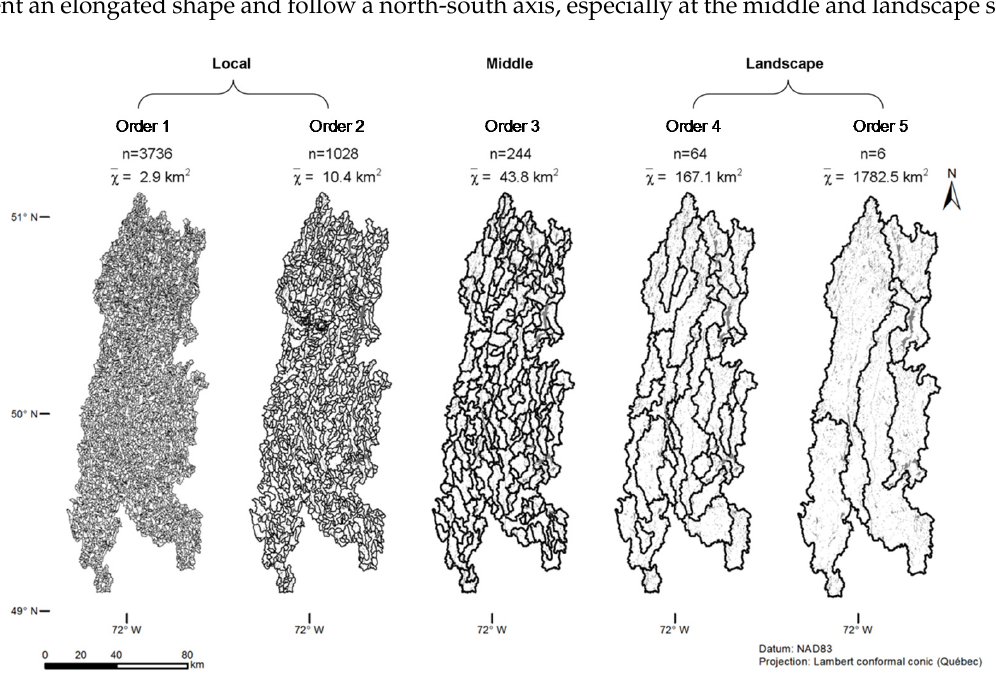
Figure 2. Watershed delineation for Strahler Orders 1–5, grouped into local (Orders 1 and 2), middle (Order 3) and landscape (Orders 4 and 5) scales. n = number of watersheds, x = mean area (km 2 ).